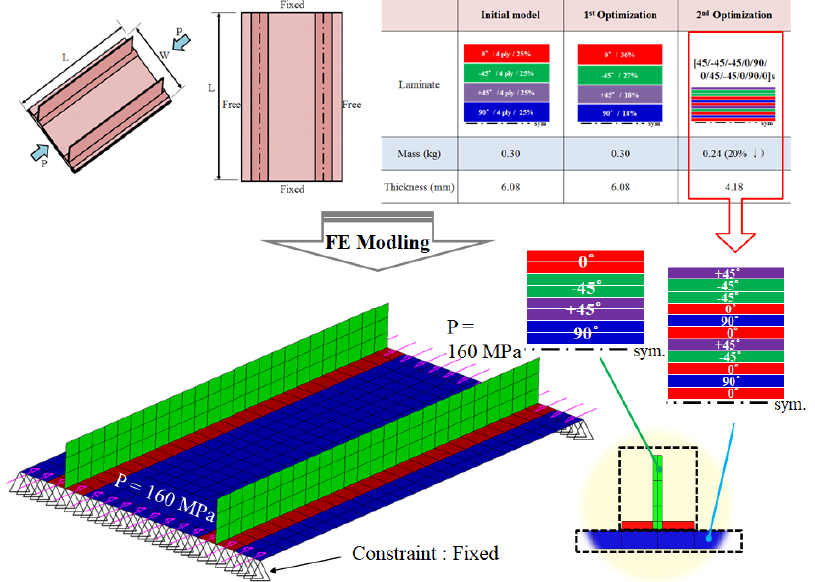
Figure 12. Finite element modeling of the blade-stiffened panel.